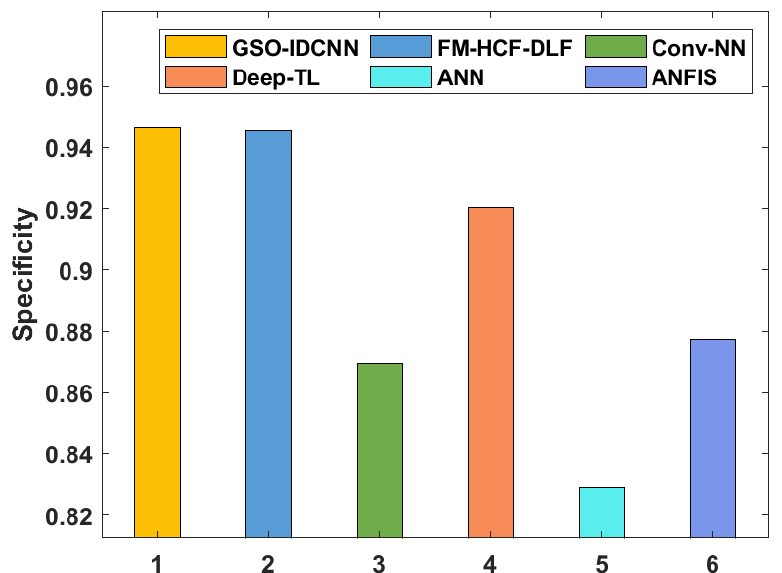
Figure 9. Comparative analysis of the GSO-IDCNN technique with respect to 𝑠𝑝𝑒𝑐 𝑦 .